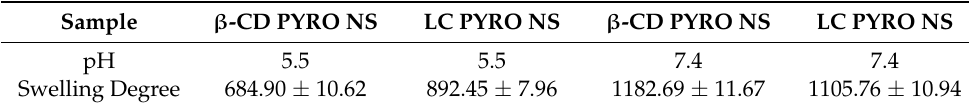
Table 4. Swelling degree of nanohydrogels at different pH